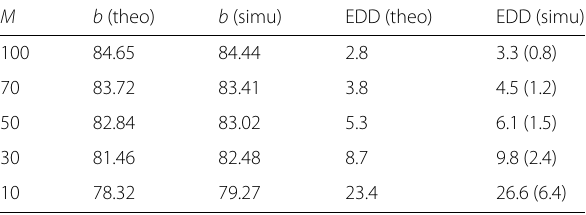
Table 2 Verification of numerical accuracy of theoretical